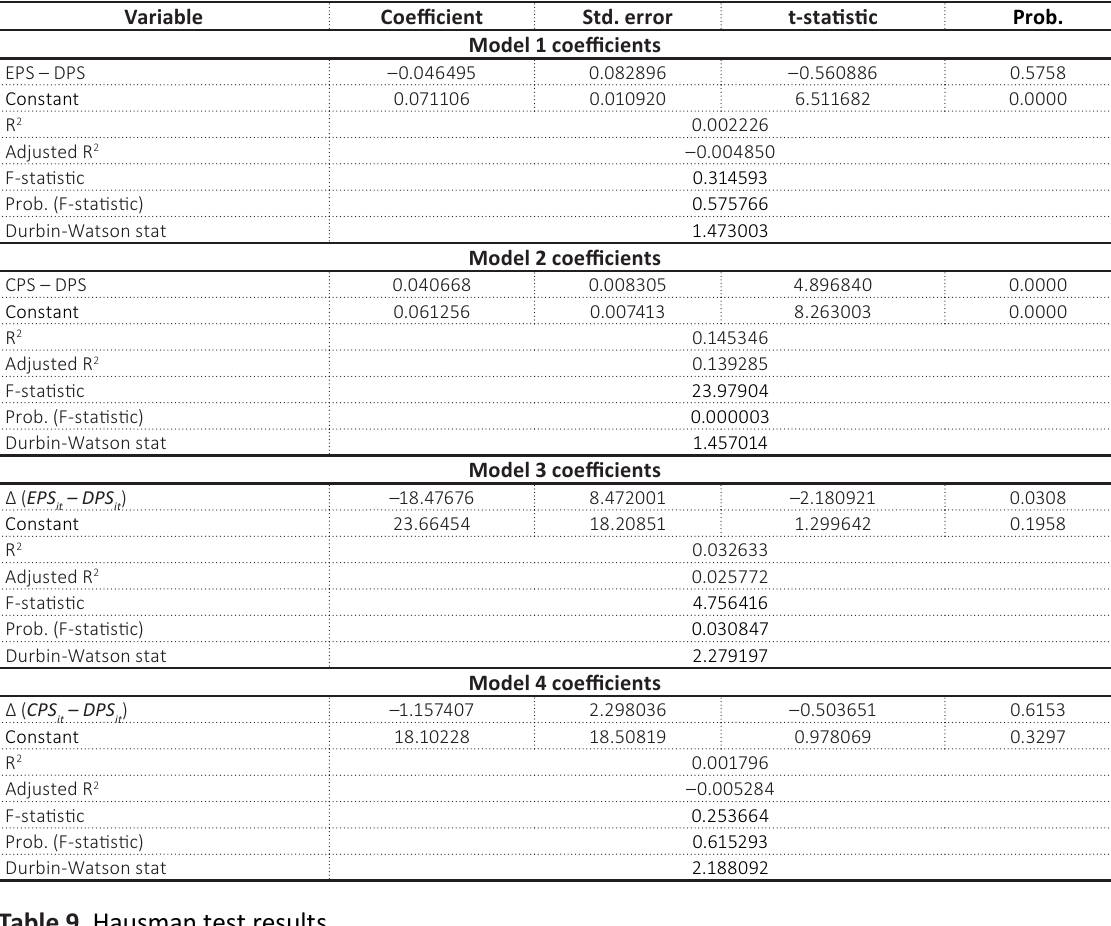
Table 8. Model coefficients